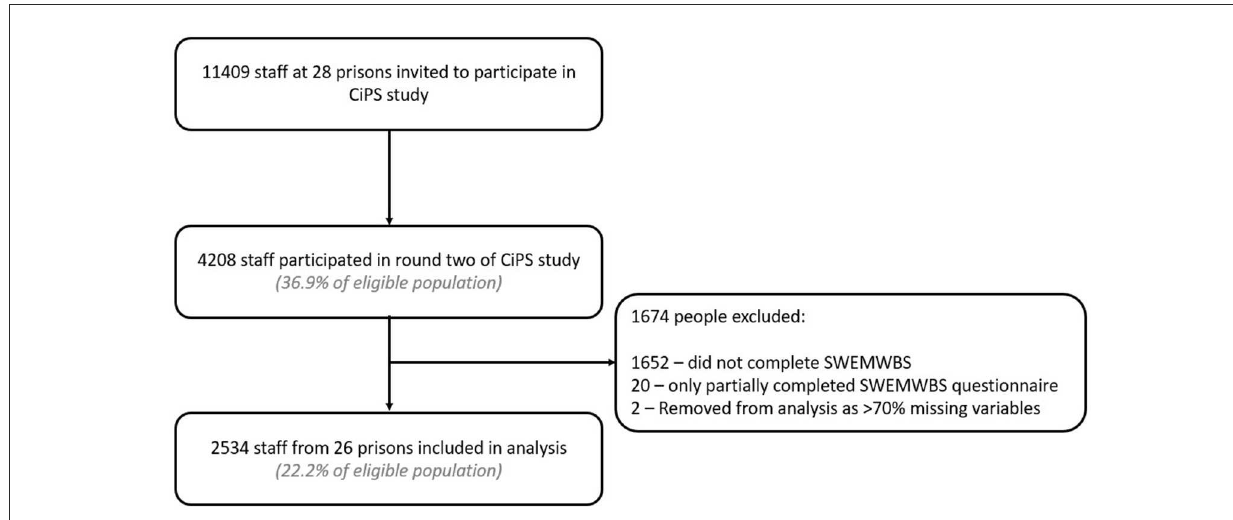
FIGURE1 Survey flowchart: eligible population, recruitment, sample included in